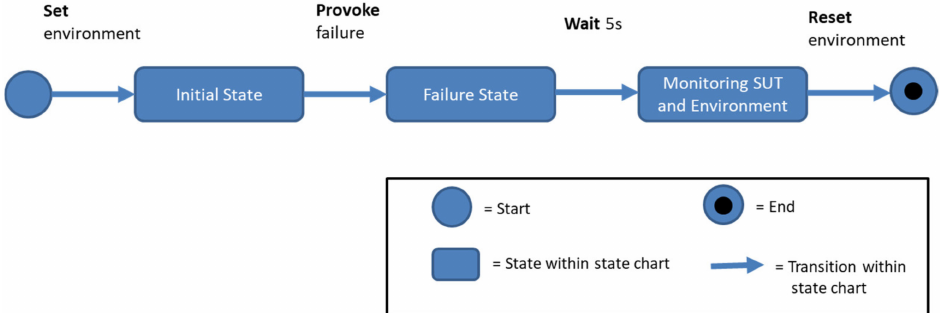
Figure 1. Basic steps of a test